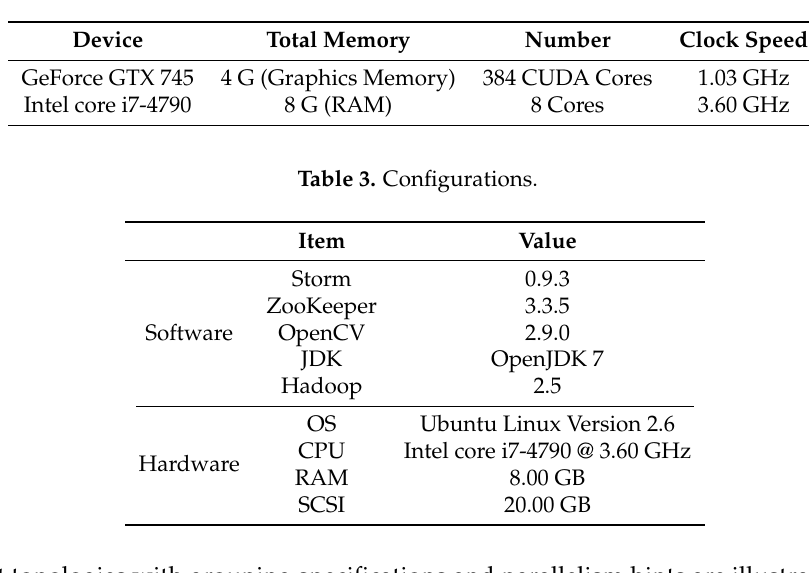
Table 2. CPU and GPU parameters for a computing node.